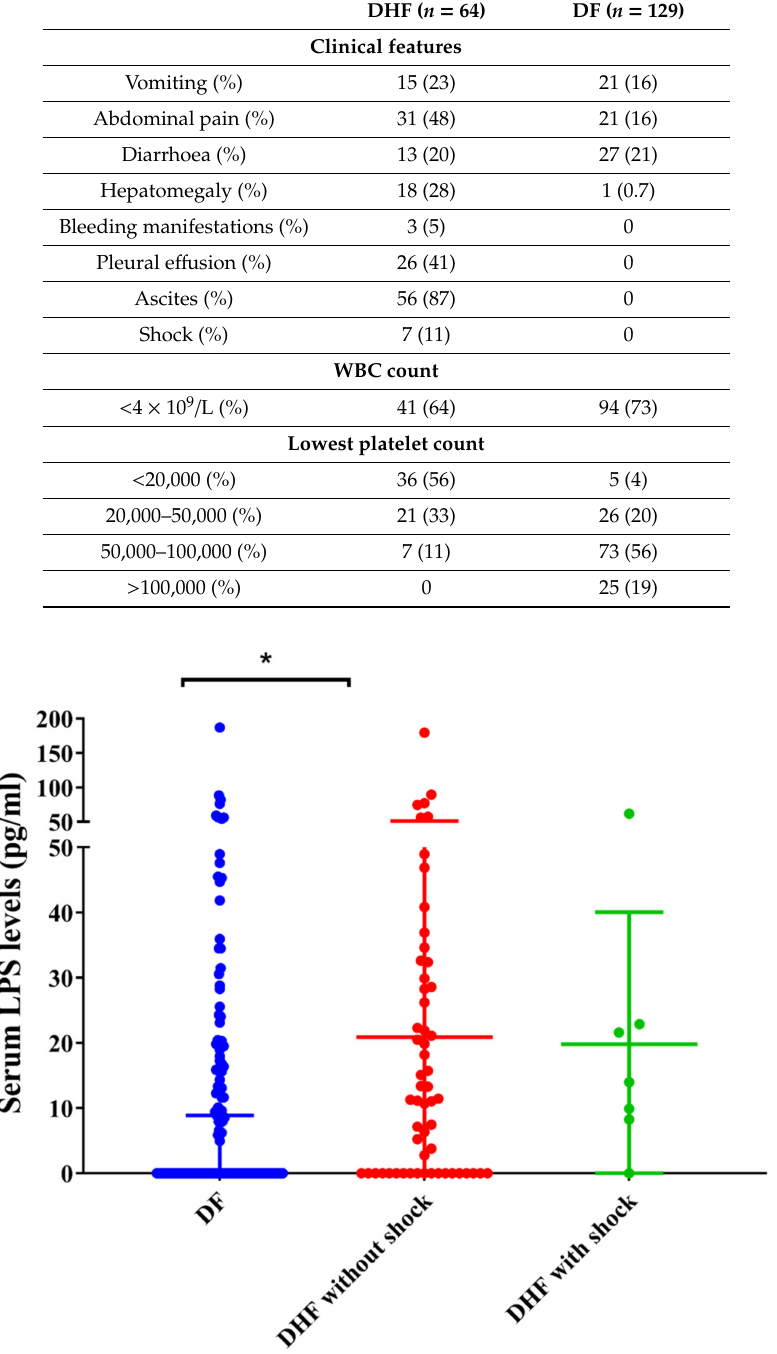
Table 1. Clinical and laboratory characteristics of patients with Dengue Haemorrhagic Fever (DHF) and Dengue Fever (DF) Recruited for the study.